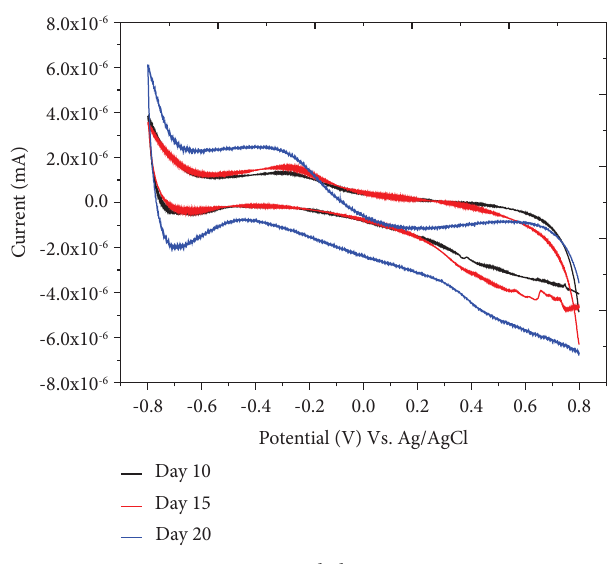
Figure 3: Recorded CV